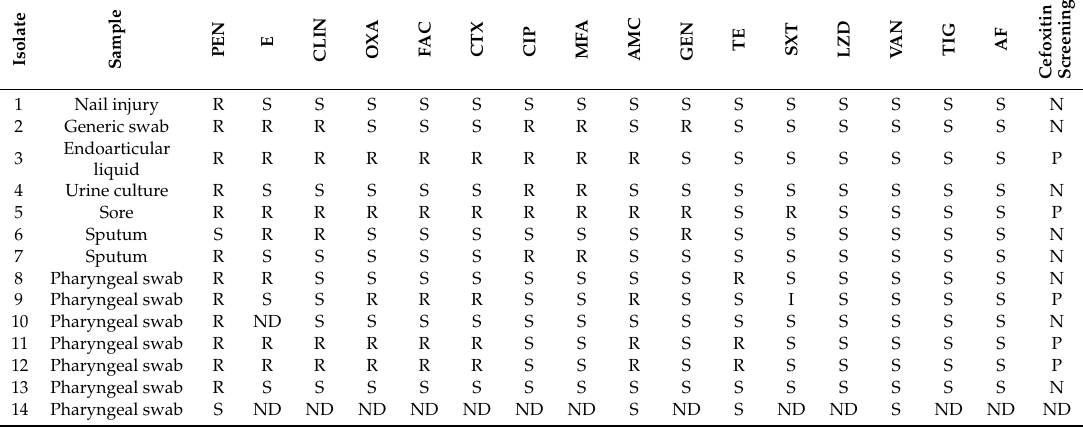
Table 1. Antimicrobial resistance profile of human isolates. The following antibiotics were tested by automatic VITEK ® 2 system: benzylpenicillin (PEN), erythromycin (E), clindamycin (CLIN), oxacillin (OXA), cefaclor (FAC), ceftriaxone (CTX), ciprofloxacin (CIP), moxifloxacin (MFA), amoxicillin- clavulanic acid (AMC), gentamicin (GEN), tetracycline (TE), sulfamethoxazole-trimethoprim (SXT), linezolid (LZD), vancomycin (VAN), tigecycline (TIG), and fusidic acid (AF). The susceptible (S), intermediate (I), and resistant (R) phenotypes are reported. P and N indicate the positivity or negativity to the cefoxitin screening. ND = not detected.